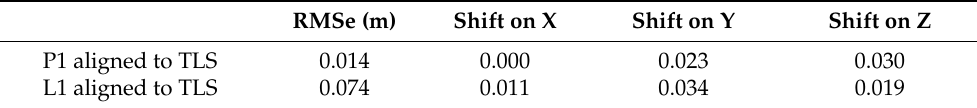
Table 13. Section no. 2—ICP registration and alignment: P1 and L1 data aligned with TLS